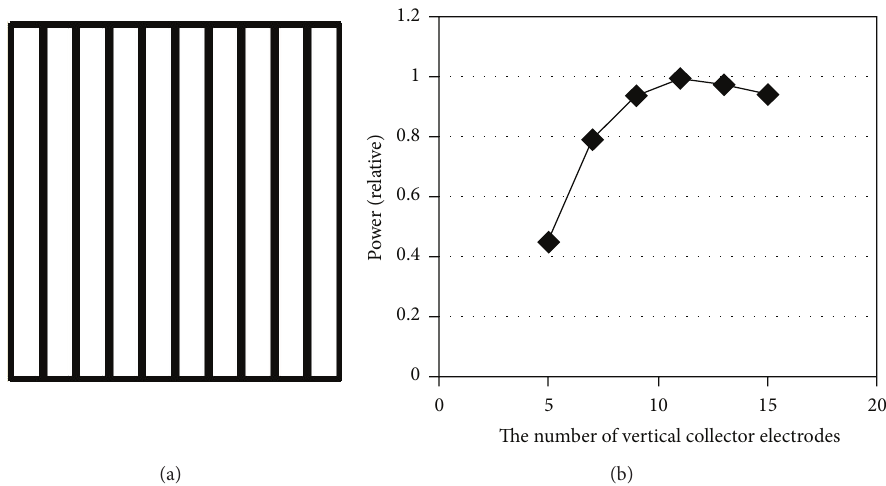
Figure 4: Geometries of standard collector electrodes and their relative power: (a) Standard geometry, (b) relative power changing with the number of vertical